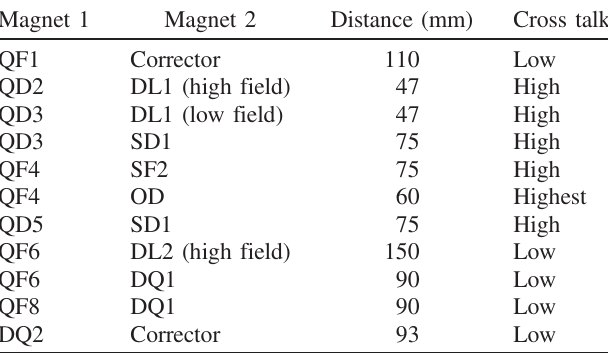
TABLE I. Longitudinal distances between magnet poles (dis- tances greater than 150 mm are not reported). Magnets QF1, QD2, QD3, QF4 and QD5 are moderate gradient quadrupoles, QF6 and QF8 are high gradient quadrupoles, SD and SF are sextupoles, OD are octupoles, DQ are combined dipole-quadru- poles and DL are permanent magnet dipoles. The last column indicates intensity of the cross talk. It is high for most of the moderate gradient quadrupoles and their neighbors.